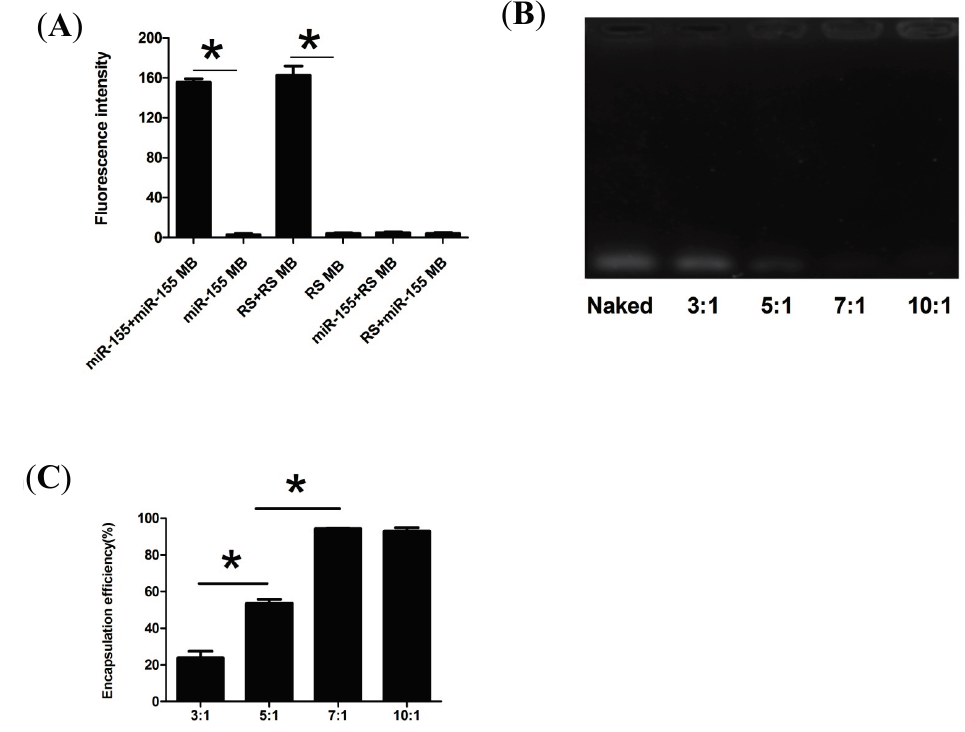
Figure 1. Synthesis of CS-MB nanoparticles complexes. ( A ) Hybridization experiments for the MBs. The fluorescence intensity of miR-155+miR-155 MB group, miR-155 MB group, RS+RS MB group, RS MB group, miR-155+RS MB group and RS+miR-155 MB group. (n = 4) ( * p < 0.05). ( B ) Agarose gel electrophoresis analysis of CS-miR-155 MB complexes. Lane 1: naked miR-155 MB, lane 2–6: the different Wcs/W miR-155 MB weight ratios ranging from 3:1 to 10:1. ( C ) The encapsulation efficiency of different Wcs/W miR-155 MB weight ratios ranging from 3:1 to 10:1. (n = 3). ( * p <